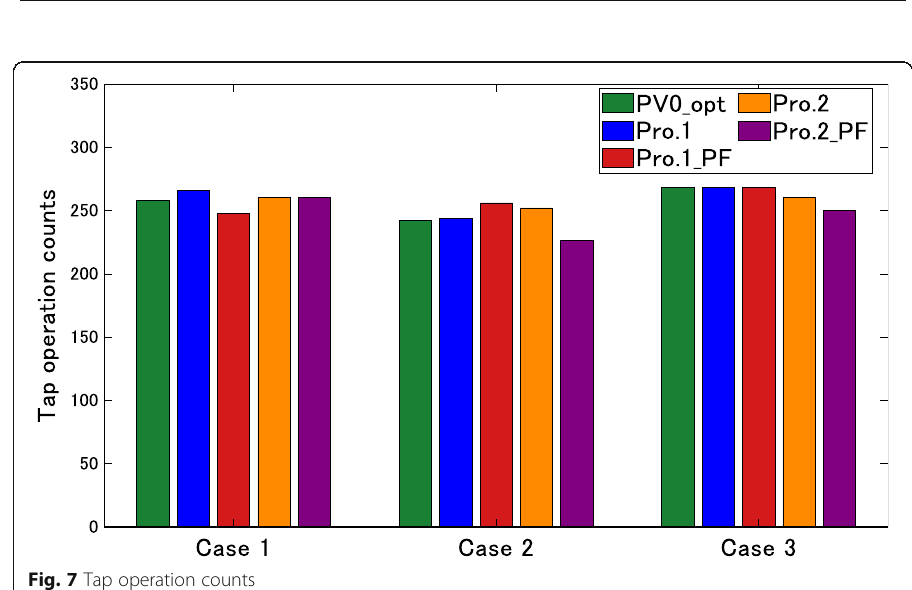
Fig. 7 Tap operation